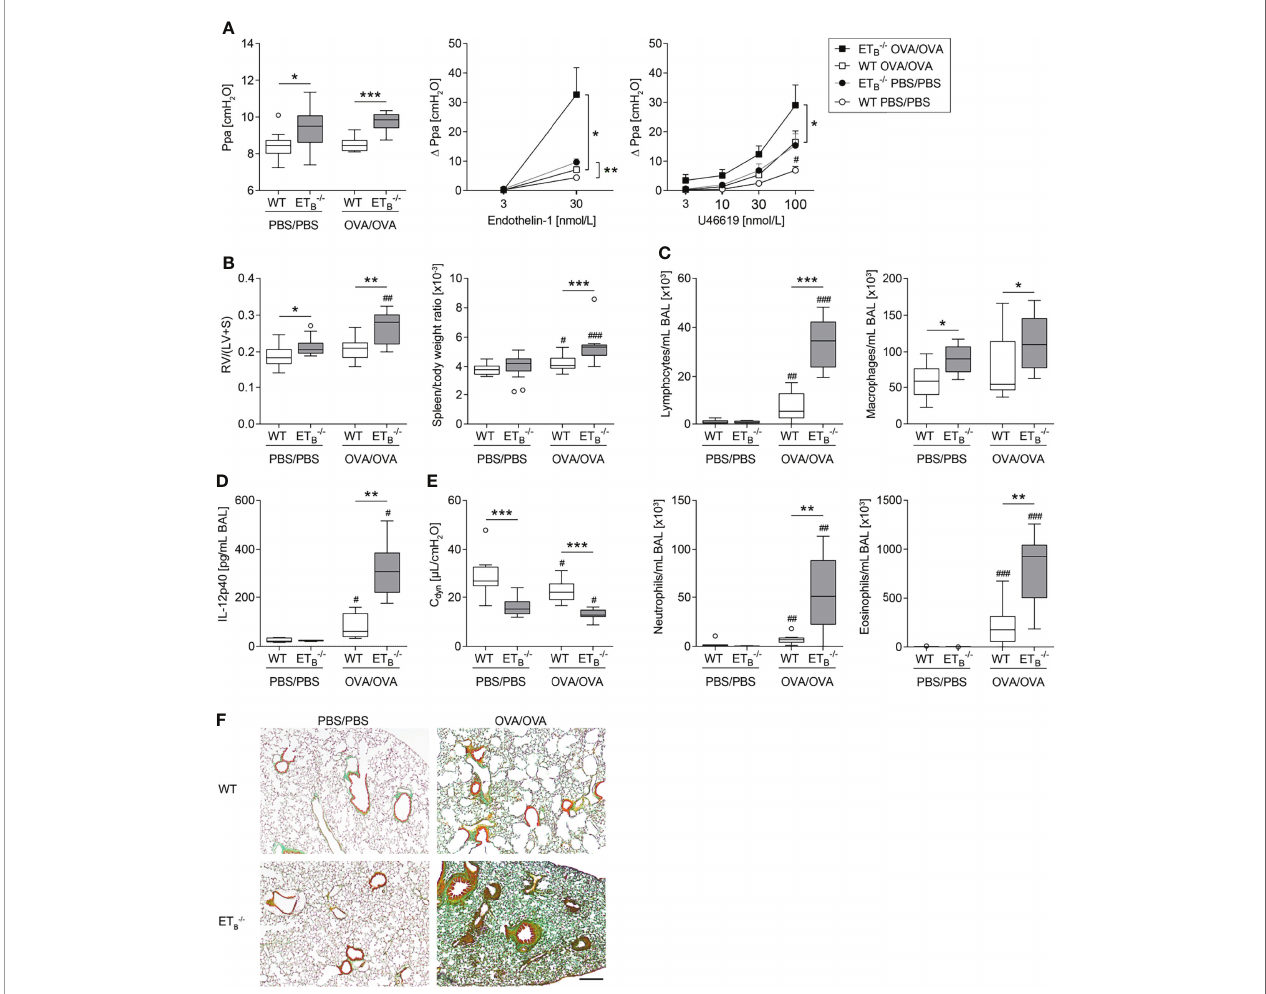
FIGURE 5 | ET B de fi ciency aggravated Th2-mediated vascular pathologies and in fl ammation in the lung. Rescued endothelin B receptor-de fi cient (ET B-/- ) and corresponding wild-type (WT) mice were systemically sensitized with ovalbumin (OVA) (or PBS as control) and repeatedly exposed to aerosolized OVA (OVA/OVA) or PBS (PBS/PBS). Forty-eight hours after the last challenge, lungs, hearts, and spleens of 12-wk-old mice were harvested, or bronchoalveolar lavage (BAL) was performed. (A) In isolated perfused and ventilated lungs, pulmonary arterial pressure (Ppa) was measured under basal conditions, and pulmonary vascular responsiveness to increasing concentrations of endothelin-1 or thromboxane receptor agonist U46619 was determined. Data ( D Ppa) represent the difference between the highest pressure response to the respective stimulus and the basal Ppa. (B) Fulton index [quotient of right ventricle (RV) and left ventricle (LV) including septum (S)] was determined after weighing the cardiac compartments (left) and spleen weight was determined and related to body weight (right). (C) Leukocytes were differentially quanti fi ed in BAL. (D) IL-12p40 was determined in BAL (lower detection limit was 0.54 pg/mL). (E) In isolated perfused and ventilated mouse lungs, dynamic lung compliance (C dyn ) was measured. (F) Lung tissue sections were stained with Masson – Goldner trichrome that revealed more pronounced pulmonary collagen deposition in ET B-/- than WT mice after OVA/OVA treatment. The scale bar represents 100 µm and is valid for all photomicrographs. Representative images ( N = 7 per group) are shown. In (A left, B – E), data are represented as box plots depicting median, quartiles, and ranges excluding outliers ( open circles ), and analyzed using Mann – Whitney U test. # indicates signi fi cant difference between OVA/OVA vs. the corresponding PBS/PBS group, * indicates signi fi cant difference between ET B-/- vs. the corresponding WT group. In (A middle-right) , values are given as mean and SEM, and analyzed using two-way repeated measures ANOVA (*). In (A right) , additional Mann – Whitney U test was performed comparing values of ET B-/- and WT mice treated with PBS at the highest dose of U46619 (#). N = 5 – 14 (A – C, E) or N = 3 – 6 (D) . * /# p < 0.05, ** /## p < 0.01, *** /### p <